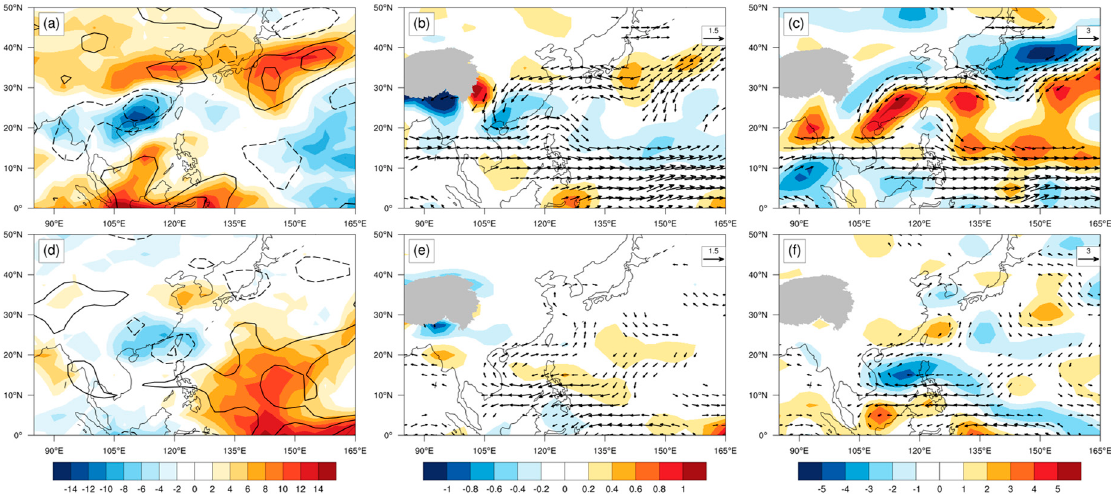
Figure 5. Composite differences of ( a , d ) vertically integrated omega from 850 to 500 hPa (contours with the interval of 2, unit: kg (m · s) - 3 ) and OLR (shading, unit: W m - 2 ); ( b , e ) vertically integrated moisture flux from 1000 to 500 hPa (vectors, unit: kg m - 1 s - 1 ) and its divergence (shading, unit:10 - 6 kg m - 2 s - 1 ); and ( c , f ) 850 hPa wind (vectors, unit: m s - 1 ) and relative vorticity (shading, unit: 10 - 6 s - 1 ) between wet years and dry years. (( a – c ) for S1; ( d – f ) for S2; significant values exceeding the 95% confidence level are displayed; the dashed/solid lines suggest values larger/smaller than zero in ( a , d )).